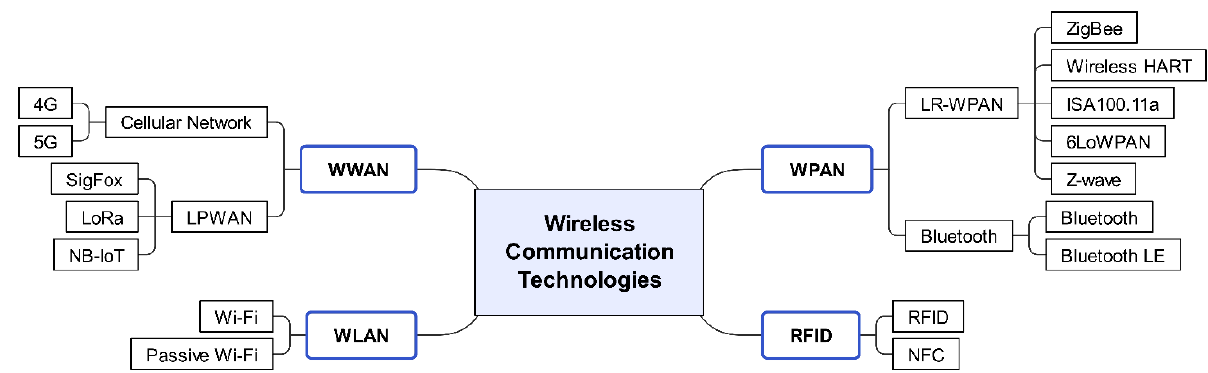
Figure 6. Wireless communication technologies.